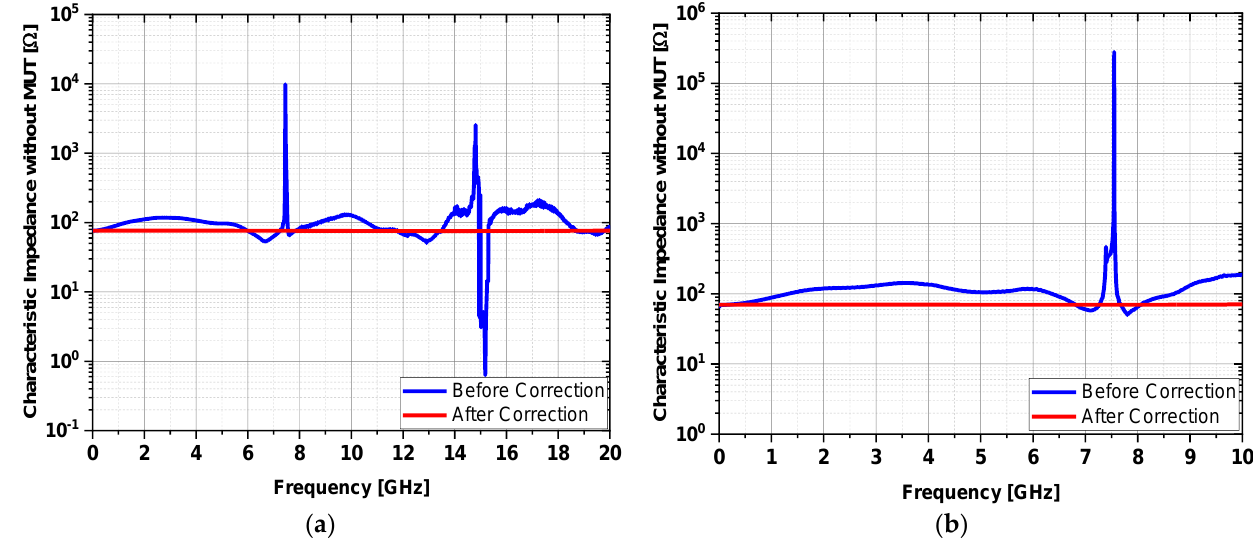
Figure 4. ( a ) Characteristic impedance of the circular coaxial fixture without the material under test (MUT); ( b ) characteristic impedance of the rectangular coaxial fixture without the material under test (MUT).